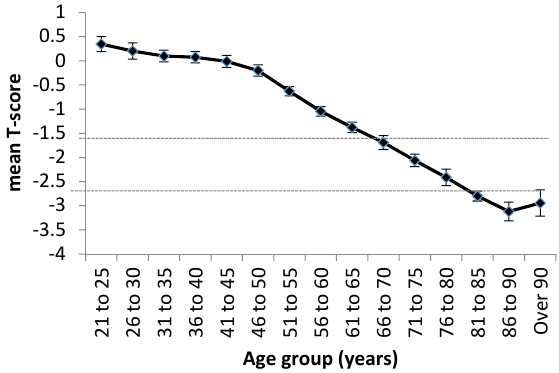
Figure 1. Mean T-scores by age group of a total of 598,757 women in Asia. Data are shown as mean ± SEM ofseven countries (Singapore, Taiwan, Thailand, Vietnam, Malaysia, Indonesia, and the Philippines). Dotted horizontal lines depict T-score cut-offs for osteopenia ( ´ 1.5) and osteoporosis ( ´ 2.5). Figure republished with permission